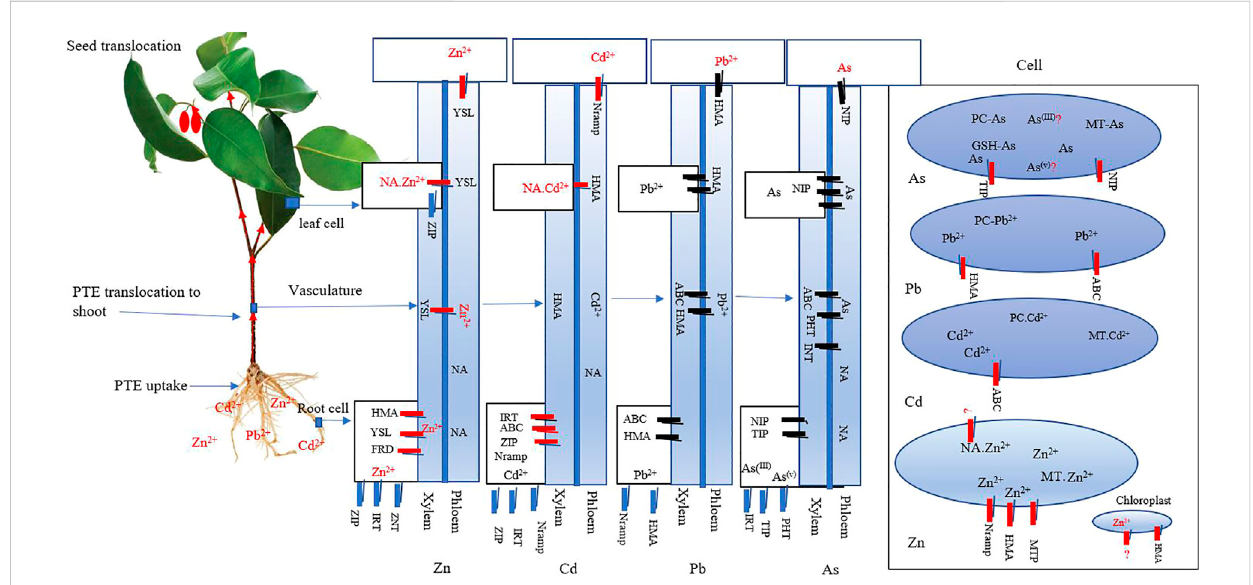
FIGURE 3 Schematic diagram showing various transporters are involved in As, Cd, Pb, and Zn uptake, transport, and sequestration in plants. Potentially toxic elements (PTEs) are taken up by root cell membrane transporters as free cations diverse transporters followed by Xylem – phloem Zn allocation occurs. The different PTEs also translocate to the leaf and seed tissues of NA-PTE complexes. Furthermore, MTs, PC, and GSH have been implicated in PTE homeostasis, transport, and sequestration in plants. Abbreviations: FRD ferric reductase defective; HMA heavy metal ATPase; IRT